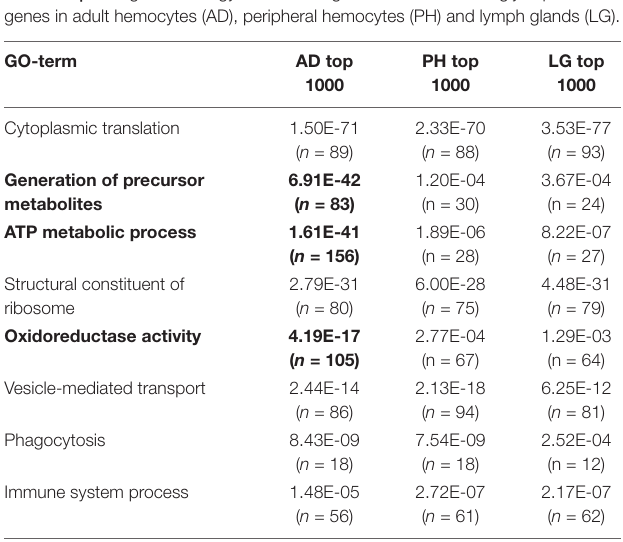
LG top 1000 1000